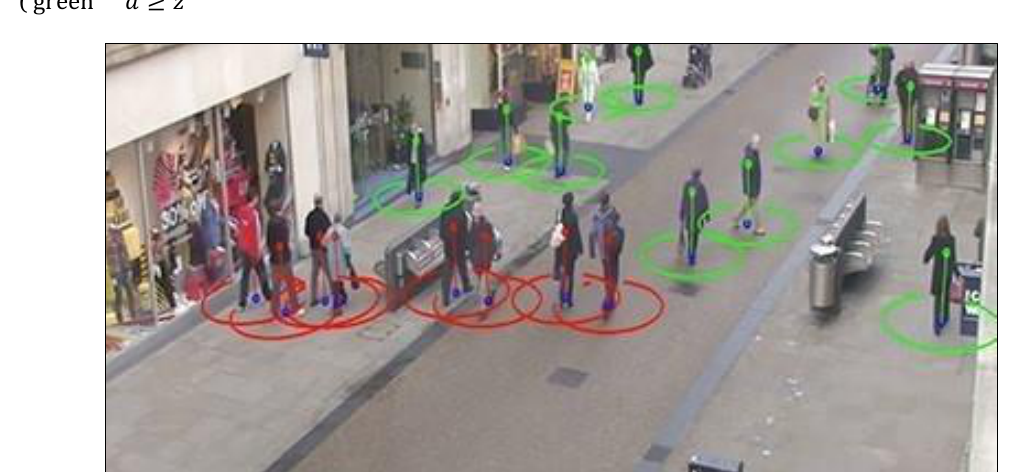
Figure 3. Top-Down Transformation.